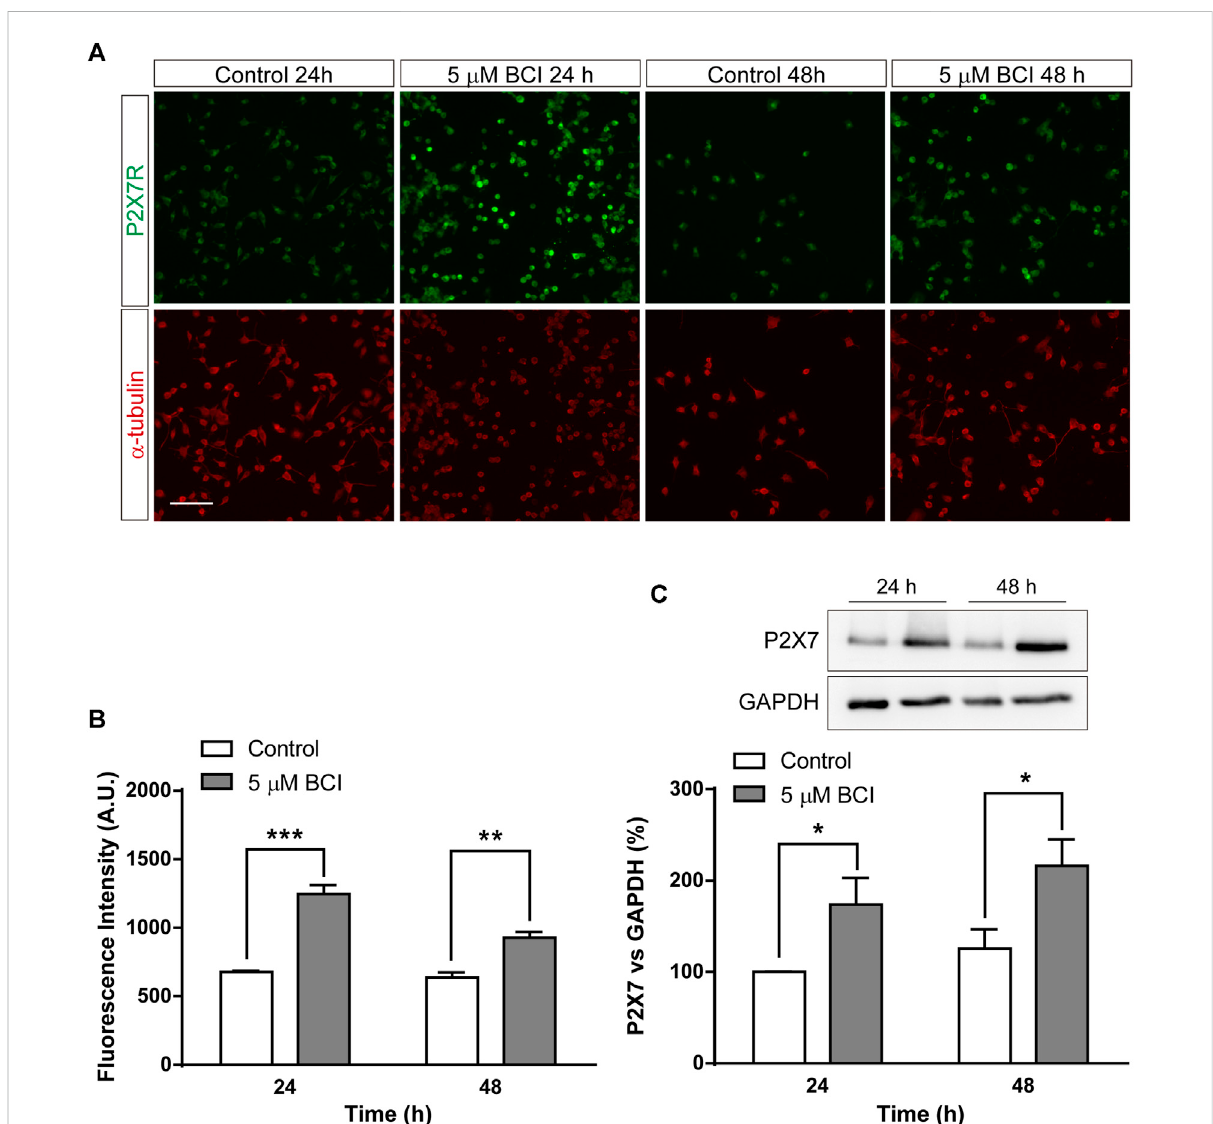
FIGURE 3 BCI increases the amount of P2RX7 protein in neuroblastoma cells. (A) Immunostaining of P2RX7 (green) and α -tubulin (red) in N2a cells culturedinSFMfor24or48 hinthepresenceorabsence(control)ofBCI(5 μ M).Scalebar=100 μ m. (B) Thehistogramrepresentsthequanti fi cation of fl uorescence intensity of P2RX7-positive cells cultured in SFM for 24 or 48 hin presence or absenceof BCI (5 μ M). The values were normalized to those obtained in control cells and the results are the mean ± SEM of four independent experiments performed in duplicate. ** p ≤ .01, *** p ≤ .001 vs. control. (C) Immunoblot depicting the presence of endogenous P2RX7R in cell lysates from N2a cells cultured in SFM for 24 or 48 h in the presence or absence of BCI (5 μ M). Western blots of the cell lysates were probed with antibodies against P2RX7R (intracellular epitope). GAPDH was used as internal loading control. The histogram shows P2RX7 protein in control and BCI-treated cells at the time points indicated, obtained by densitometry and normalized to GAPDH. The values represent the mean ± SEM of four independent experiments in duplicate. * p ≤ .05, vs. control.